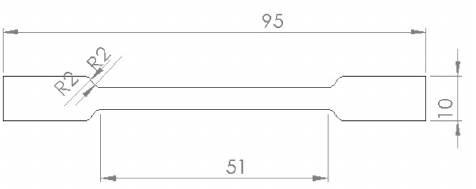
Figure 5. Dimensions of 3D printed resin bars (2 mm thick specimens) for tensile